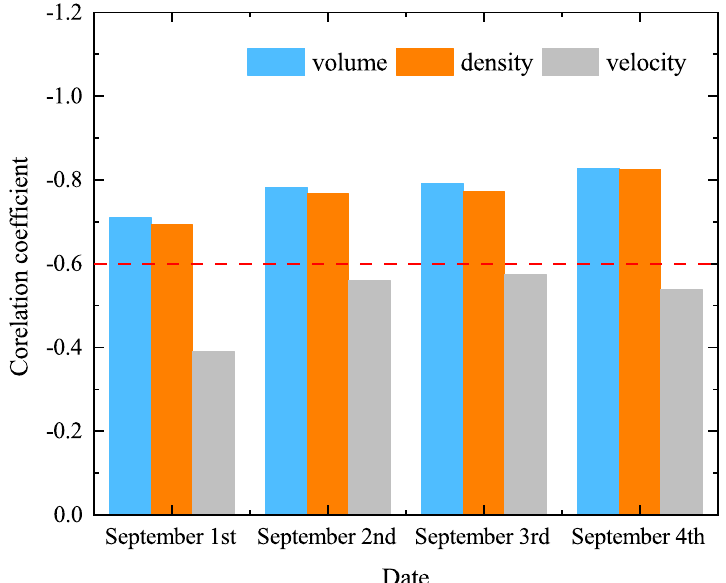
Figure 14. Values of correlation